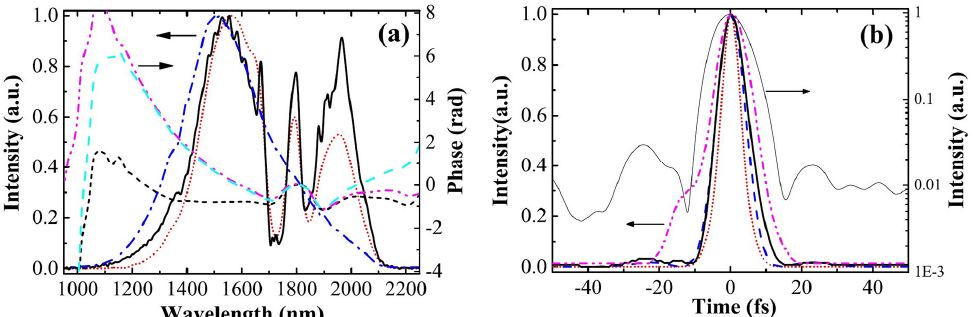
Figure 15. ( a ) Measured spectra of the TG signal (blue dash-dotted line), the testing pulse (black solid line), and the reconstructed spectrum of the testing pulse (red dotted line); reconstructed spectral phase obtained by TG-SRSI with (black dashed line) and without (magenta dash-dot-dotted line) the 1-mm-thick fused silica plate located at the Brewster angle; and calculated spectral phase without the glass plate (cyan dashed line). ( b ) Reconstructed temporal profile of the testing pulse with (black and gray solid lines) and without (magenta dash-dot-dotted line) the 1-mm thick glass plate, where the pulses were 10.6 and 15.1 fs, respectively; FTL temporal profile of the testing pulse (blue dashed line) and the TG signal (red dotted line), where the testing pulses were 9.6 and 6.8 fs, respectively [60].